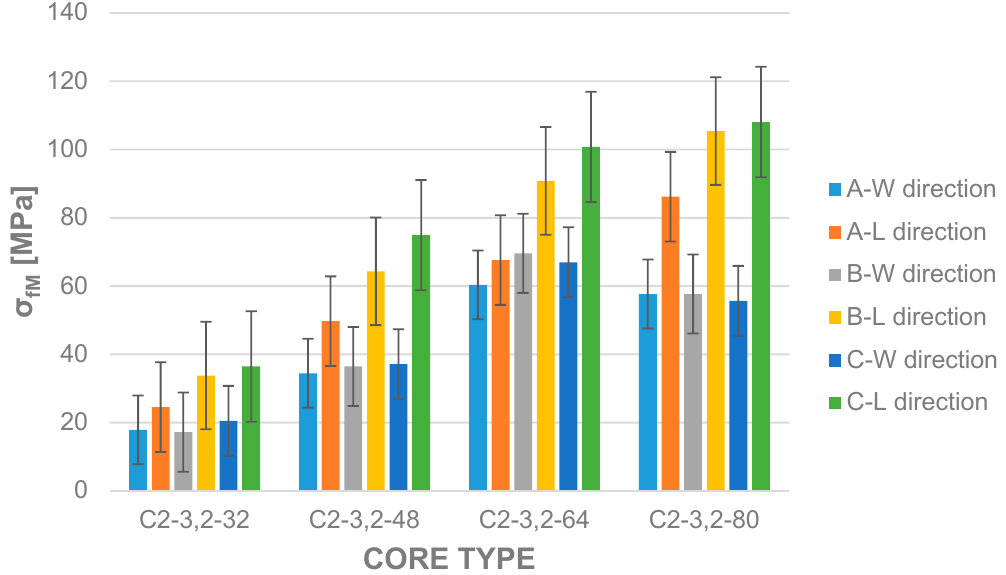
Figure 12. Influence of honeycomb geometry with mesh size (3.2, 4.8, and 6.4) mm on the bending modulus of sandwich constructions A–C.